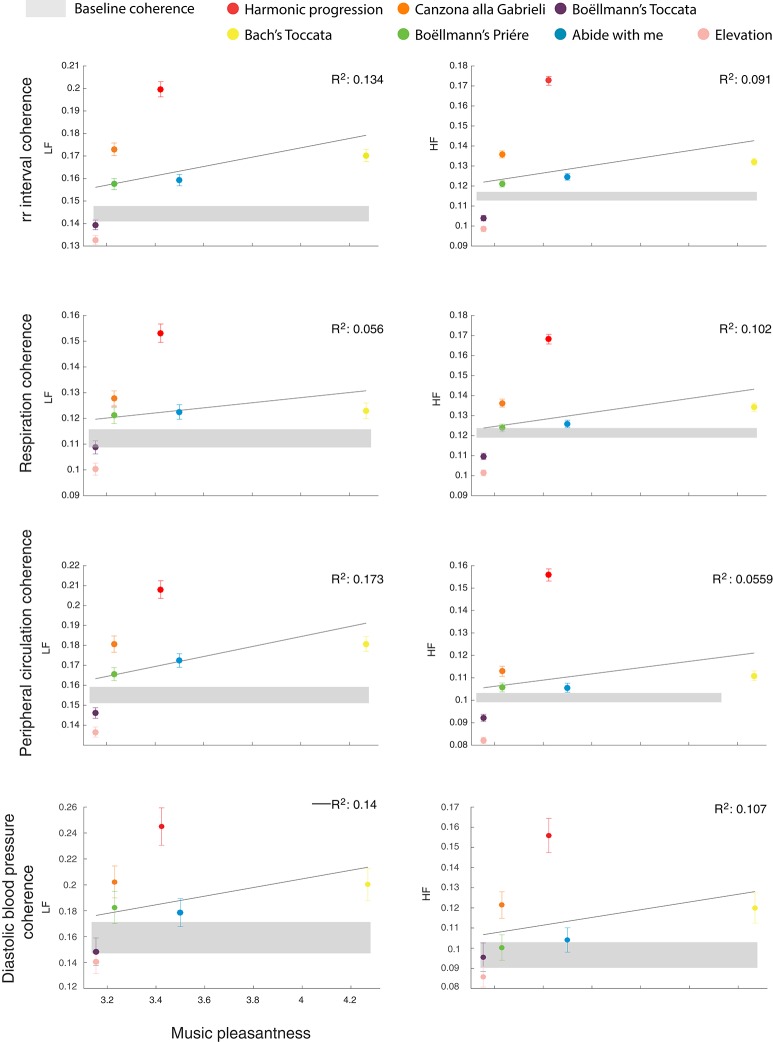
Changes in group synchronization show weak dependence on subjective music appreciation. Conventions are the same as in Figure 2, but here group synchronization is plotted as a function of subjective ratings of music pleasantness. A trend can be noticed toward greater group synchronization for music that is perceived as more pleasant, but the amount of variance in synchronization explained by this factor is low.